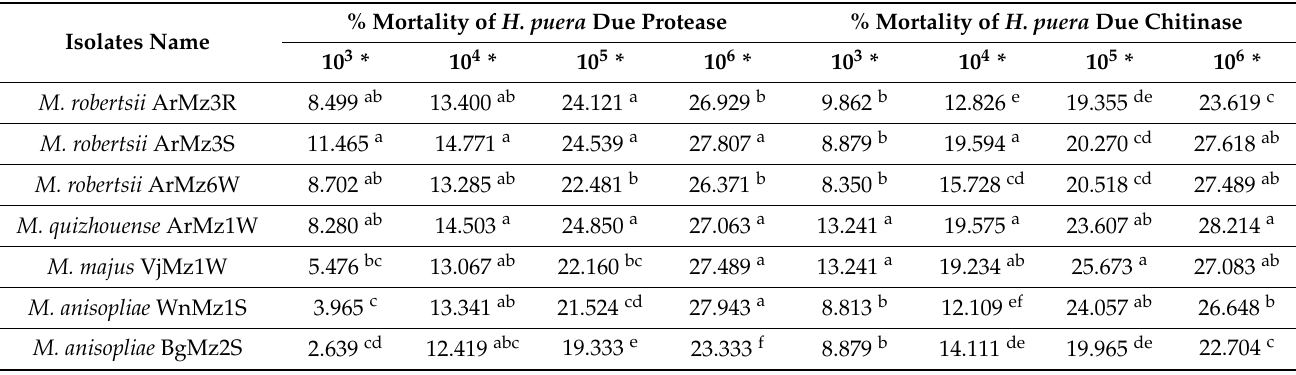
Table 2. Virulence of Entomopathogenic fungi isolates against the third-instar larvae of H. puera